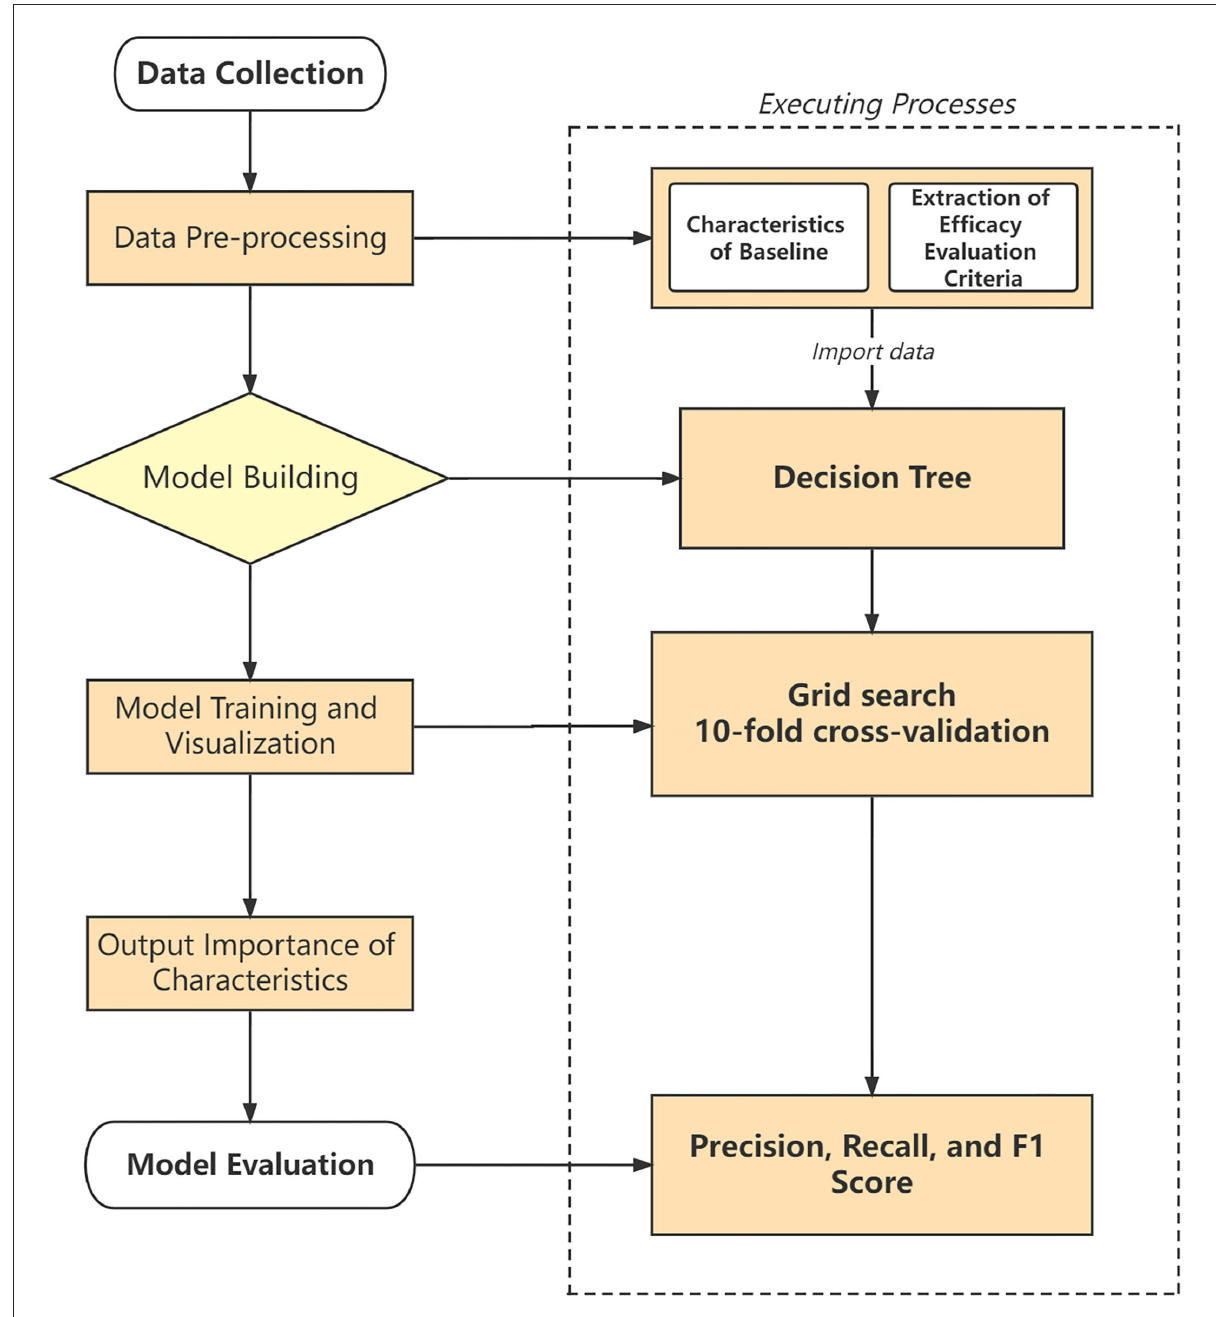
FIGURE1 Study design and technical